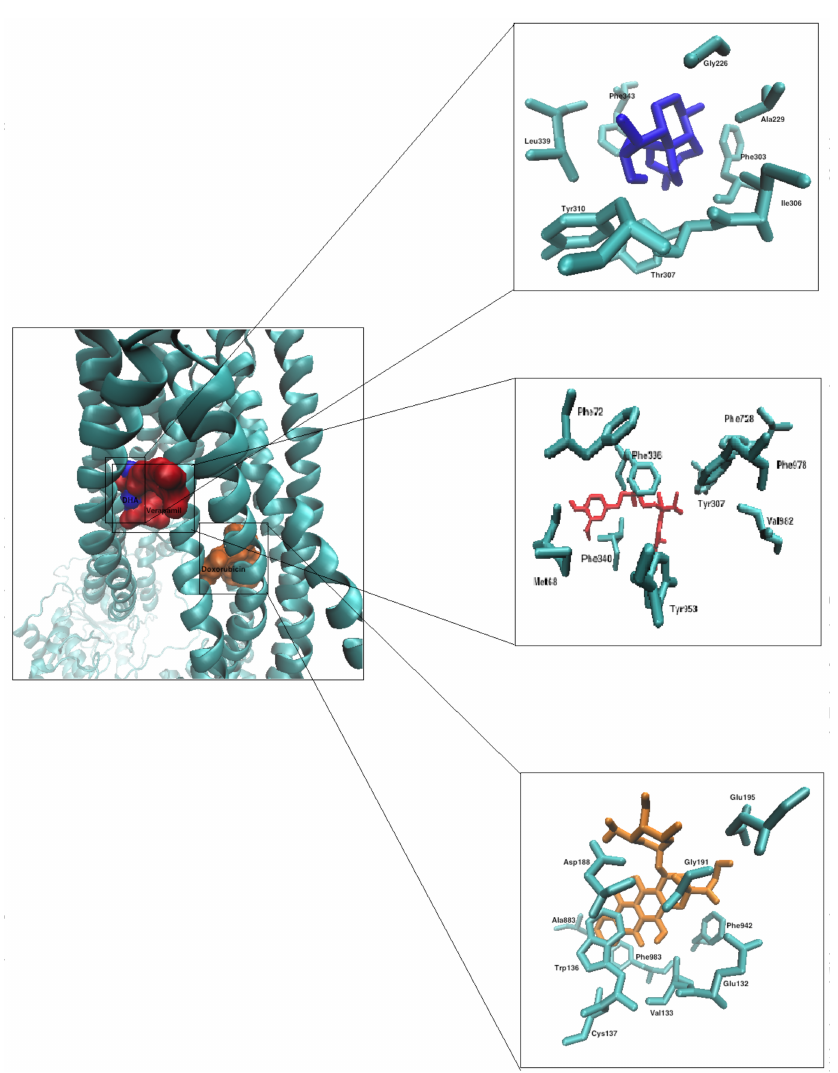
Figure 2. Molecular Docking of dihydroartemisinin (blue), verapamil (red), and doxorubicin (orange) to P-glycoprotein (represented in a new cartoon style shown as cyan), corresponding interacting amino acids are shown for each